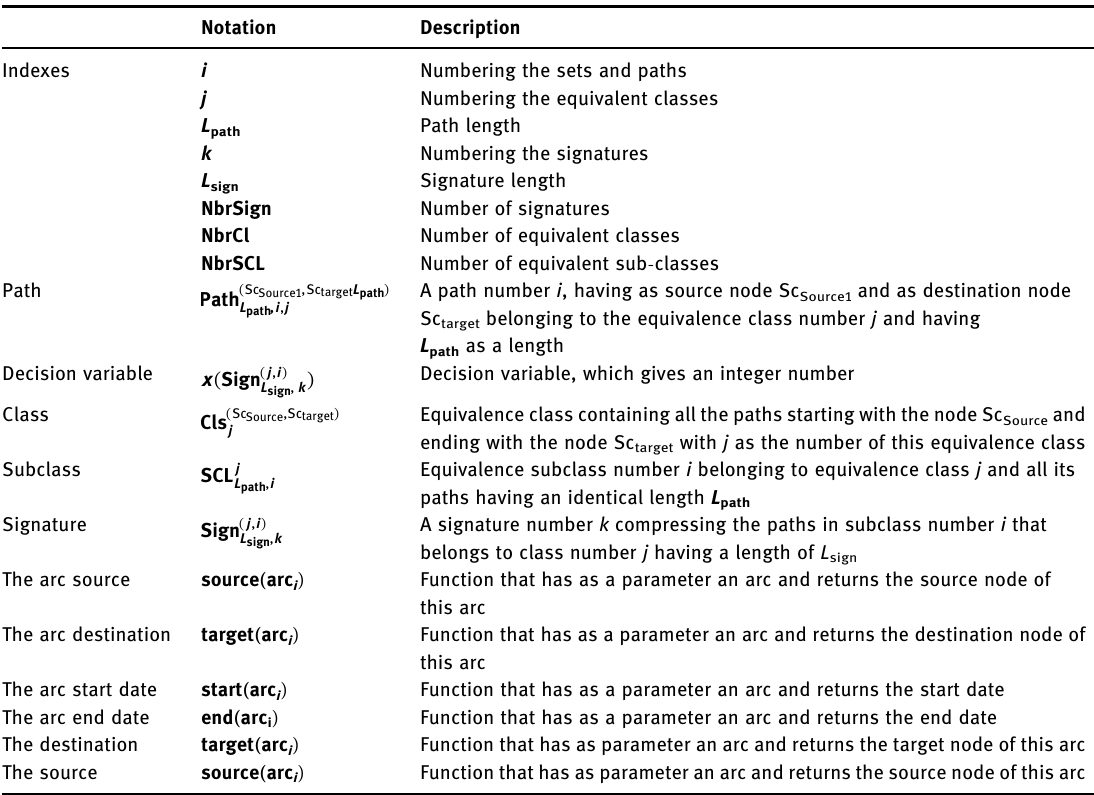
Table 2: Parameters used in the mathematical